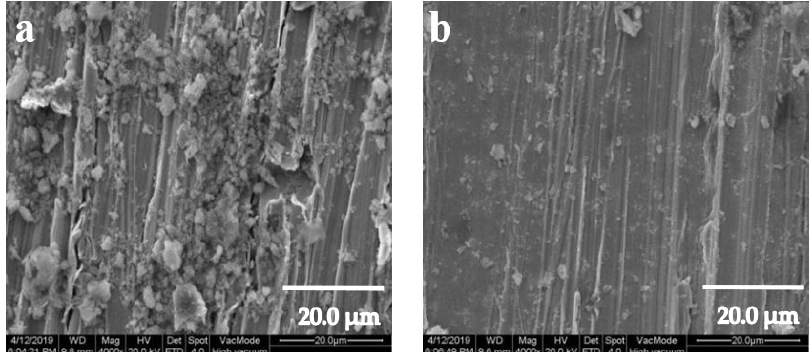
Figure 6. SEM image of self-cleaning on copper sheet surfaces: ( a ) unmodified with stearic acid (SA); ( b ) modified with SA.